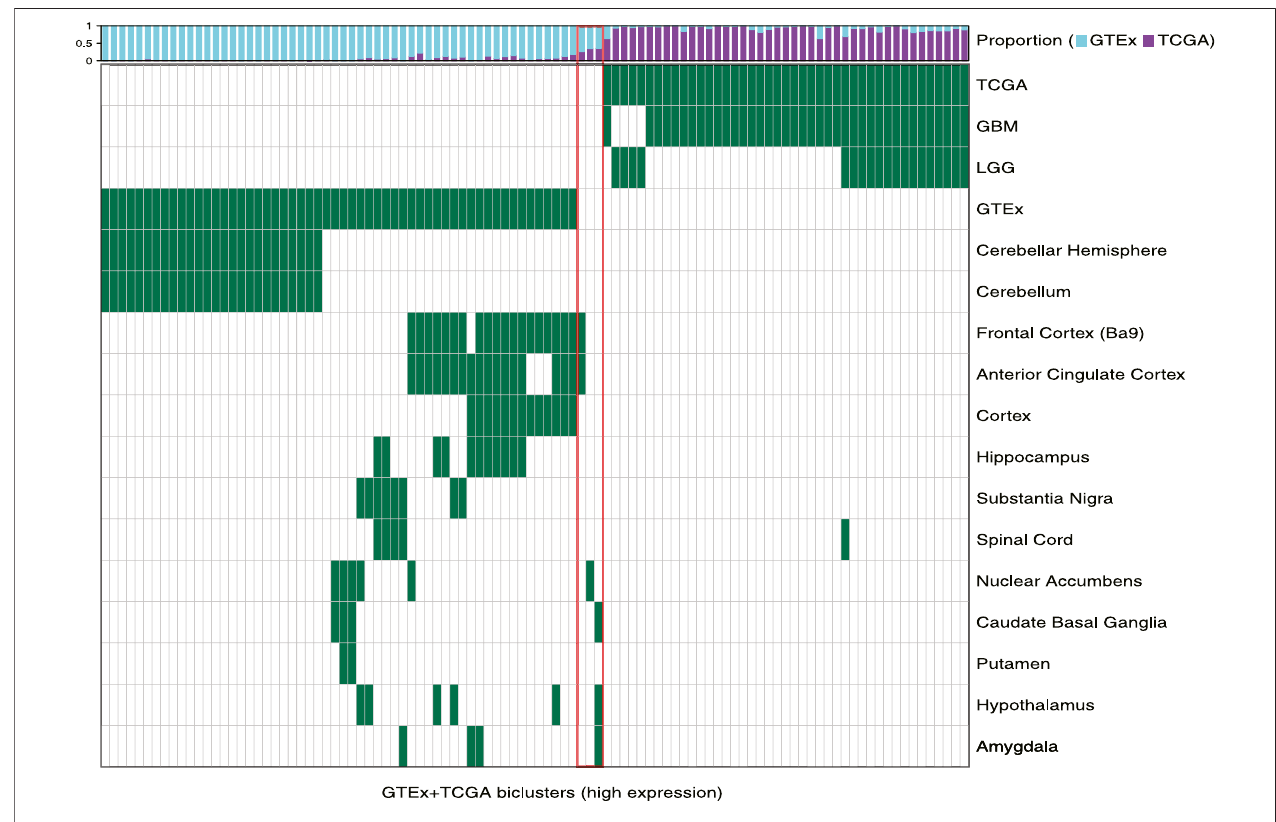
FIGURE 1 | Biclusters from TuBA ’ s high expression analysis, either enriched in the GTEx normal tissue collected from different brain regions or enriched in the TCGA tumors with LGG or GBM subtypes. The bars show the proportion of GTEx vs. TCGA samples in each bicluster. The red box highlights the three biclusters with enrichment in neither TCGA nor GTEx samples, including the cilium bicluster (most left) with enrichment in amygdala, hypothalamus, and caudate normal